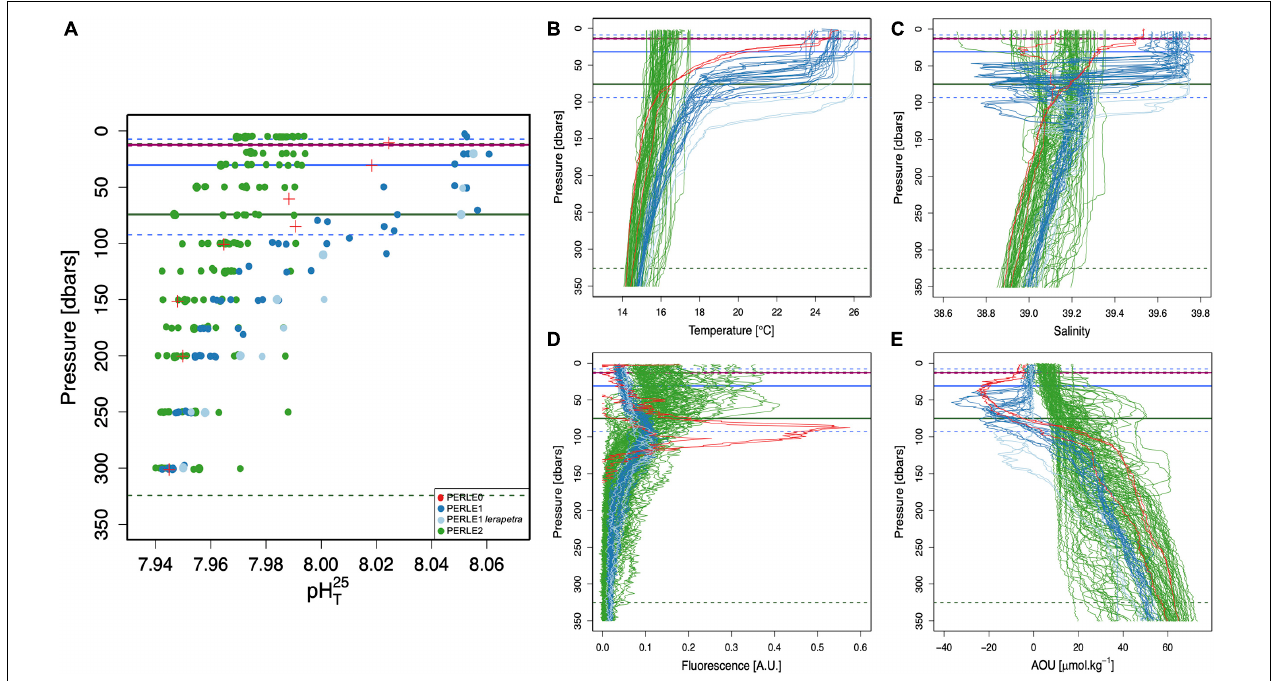
FIGURE 3 | Vertical profiles of pH in total scale at 25 ◦ C (pH T 25 , A ), temperature ( ◦ C, B ), salinity (C) , fluorescence (A.U., D ) and AOU concentrations (O 2 sol —O 2 mes ; µ mol.kg − 1 , E ) above 350 dbars for all stations in the North Western Levantine Basin during the three PERLE cruises. Horizontal full lines represent the mean Mixed Layer Depth (MLD; dbars). Dotted lines represent the minimum and maximum MLD values, respectively. For PERLE1, a distinction is made between inside (light blue lines) and outside (dark blue lines) the Ierapetra